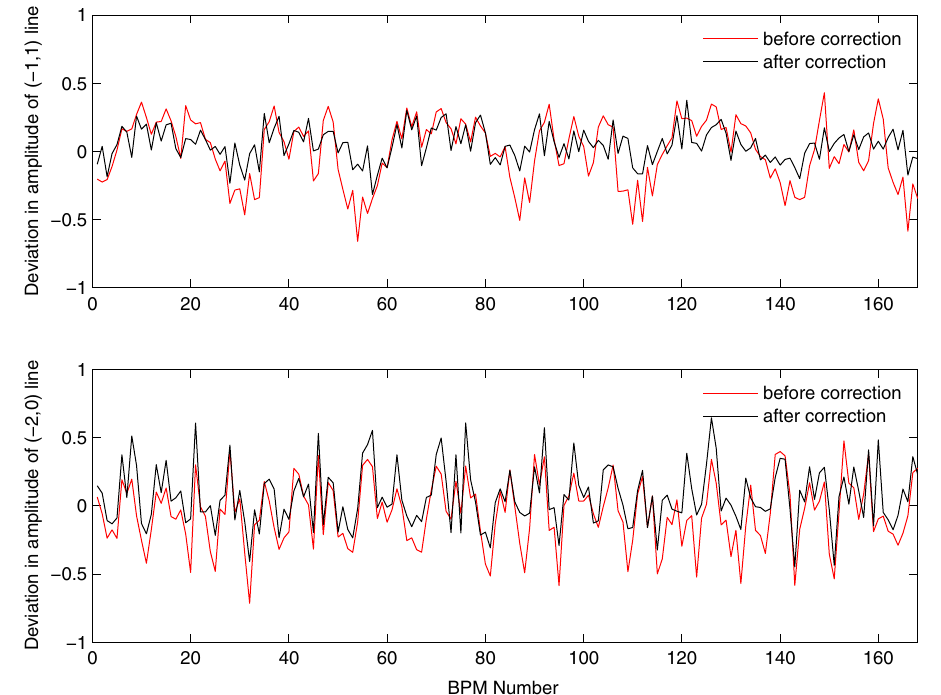
FIG. 8. (Color) Simultaneous reduction of the ð(cid:1) 1 ; 1 Þ line in the vertical plane and of the ð(cid:1) 2 ; 0 Þ line in the horizontal plane after the sextupole component variation determined by the fit procedure.